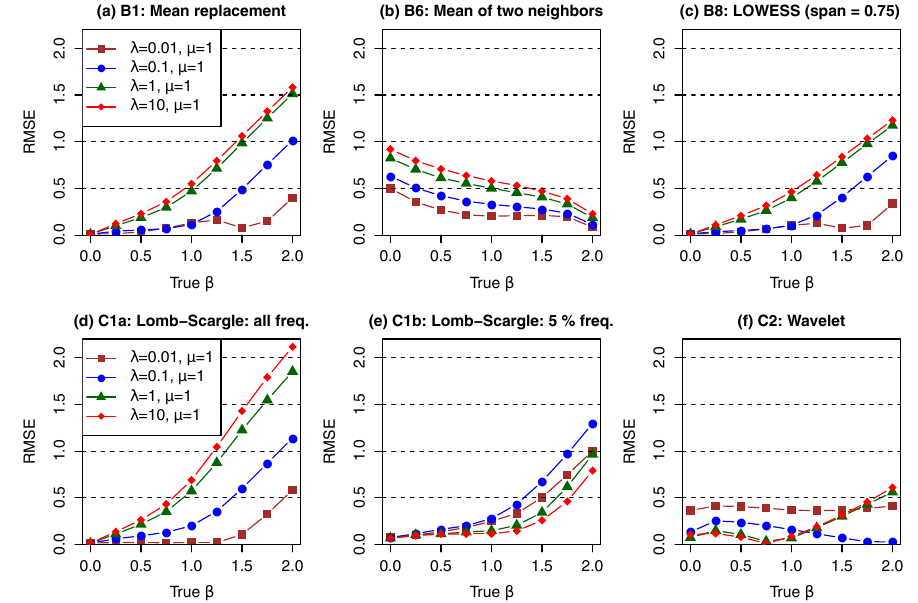
Figure 7. Comparison of root-mean-squared error (RMSE) in estimated spectral slope in irregular data that are simulated with varying prescribed β values (100 replicates), a series length of 9125, and a mean gap interval of 2 (i.e., µ = 1).